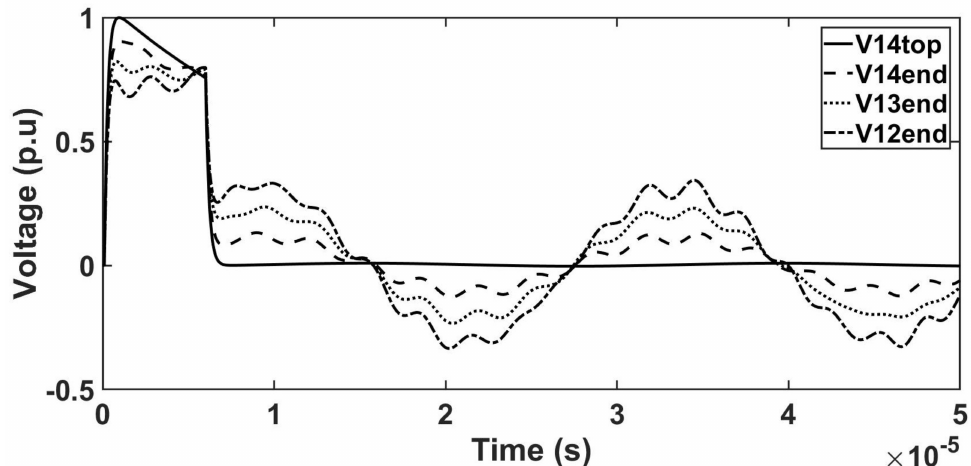
Figure 23. Surge voltage waveforms in a winding with shield between layer 14 and layer 13 and between layer 13 and layer 12 due to CLI.